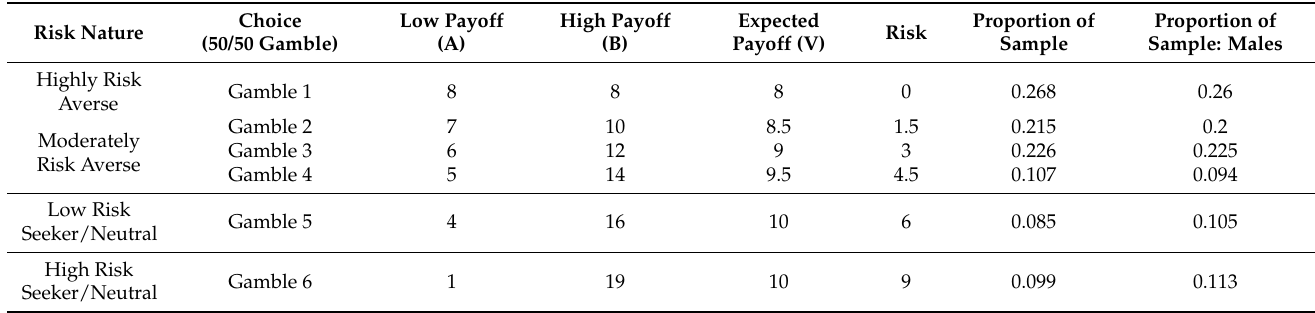
Table A3. Summary Statistics of BEG task 1.